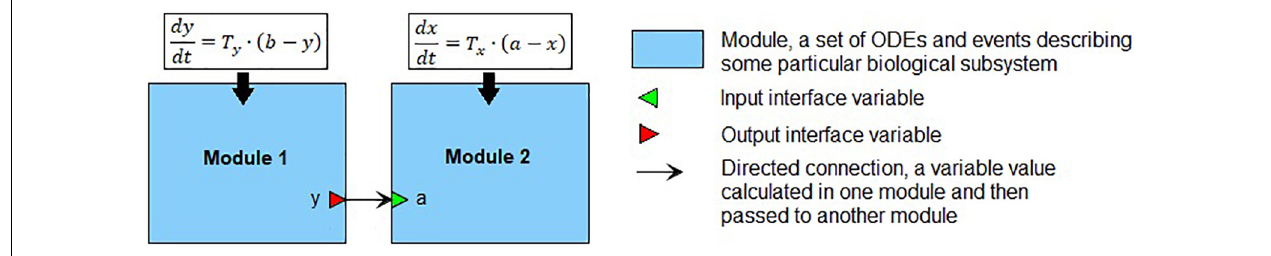
FIGURE 1 | An example of the modular representation of a two-equation model. Module 1 includes one ODE for y (output interface variable), as well as two parameters b and T y . Module 2 comprises one ODE for x , one input interface variable a , and one parameter T x .